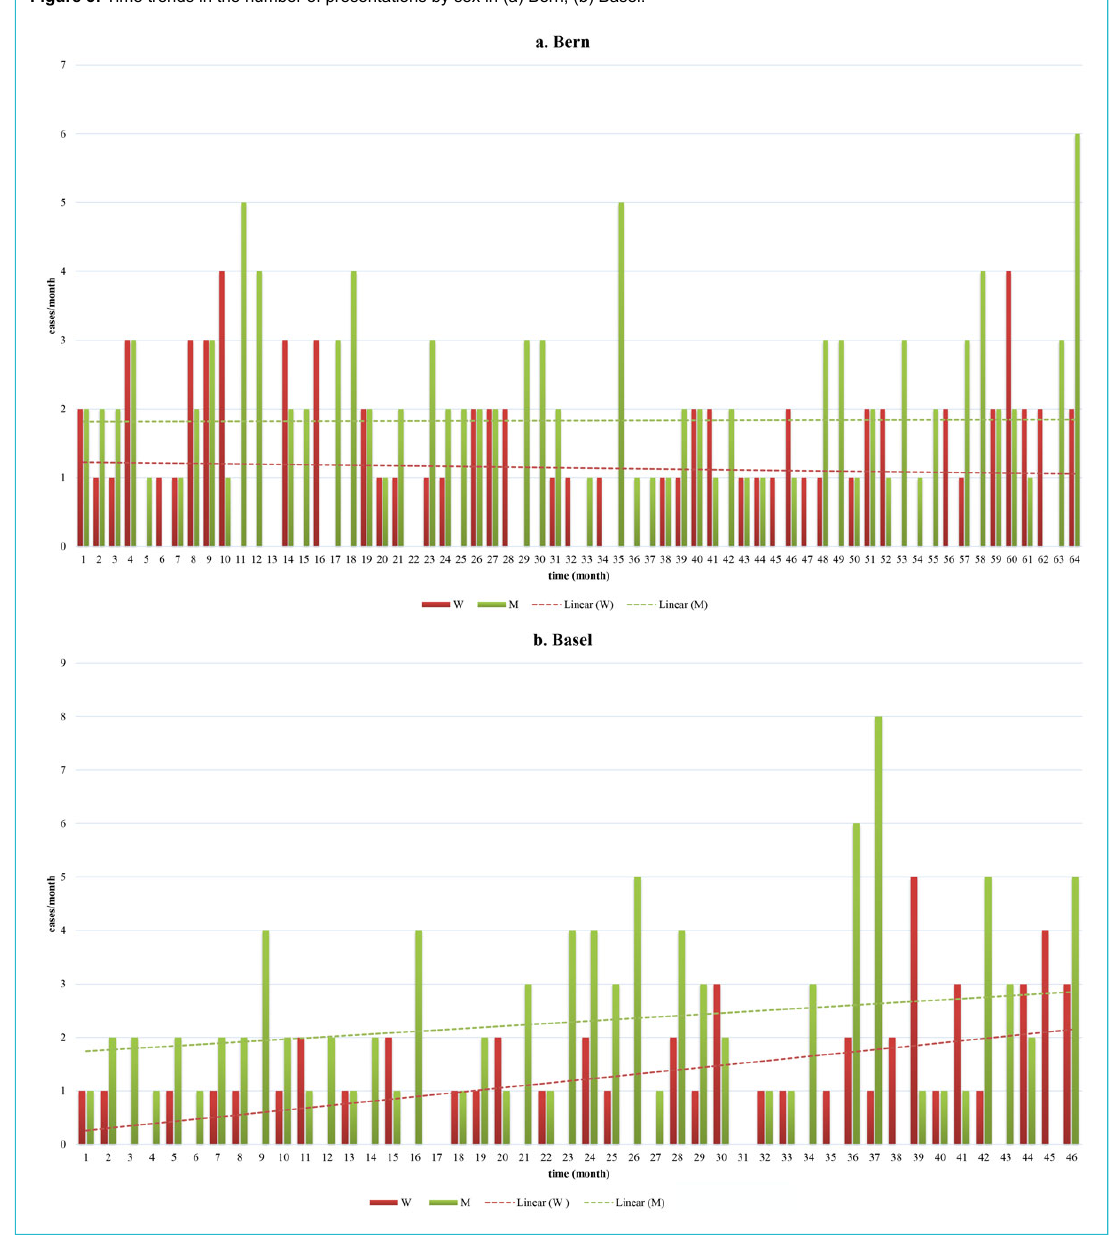
Figure 3: Time trends in the number of presentations by sex in (a) Bern, (b)